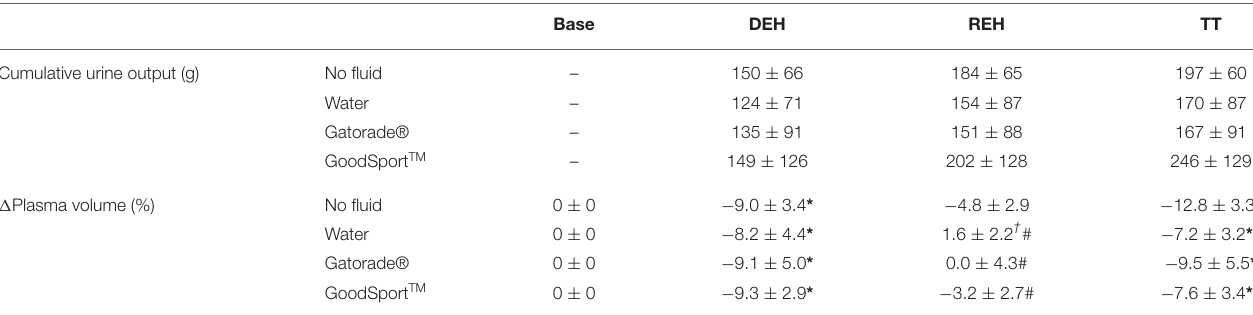
Table 4 . There was a main effect of beverage ( p < 0.001) and time ( p < 0.001), as well as an interaction effect of beverage × time ( p = 0.006). 1 %PV was significantly lower in all four trials after DEH (all p < 0.0001). There were no differences in 1 %PV at DEH between drink conditions and 1 %PV was not different after REH compared to BASE in any drink